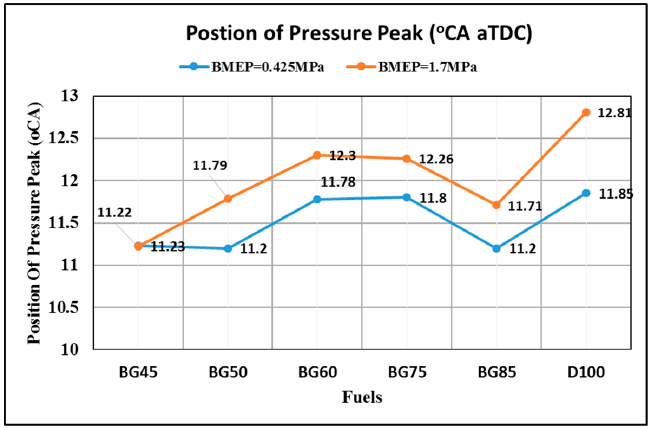
Figure 8. Variations of in-cylinder pressure with crank angle for diesel and biogas-diesel fuels. ( a ) brake mean effective pressure (BMEP) = 0.45MPa, ( b ) BMEP = 1.7MPa